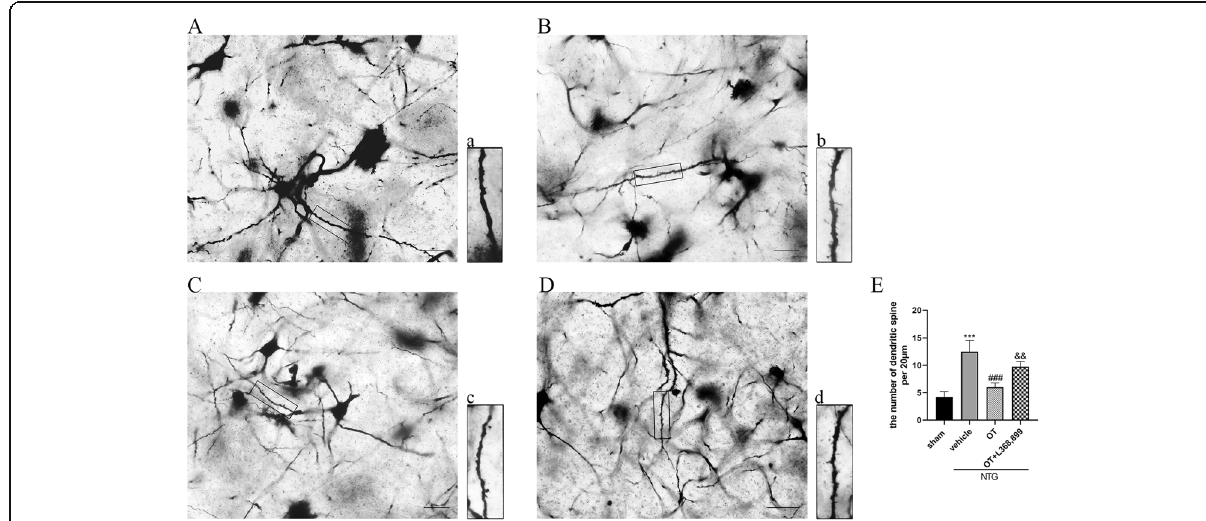
Fig. 8 Representative images and quantitative analysis of the dendritic spines in the TNC. A and a show the sham group, B and b show the NTG + vehicle group, C and c show the NTG + OT group, D and d show the NTG + OT + L368,899 group. a-d Magnification of the rectangle frame from each group was used to quantify the spine density in the four groups. E Golgi-Cox staining showed that the number of dendritic spines per 20 μ m was significantly higher in the NTG + vehicle group than in the sham group. The number of dendritic spines after OT treatment was reduced, while the effect of OT was inhibited by L368,899. One-way ANOVA with Dunnett ’ s post hoc test, n = 4/group; *** p < 0.001 vs. the sham group; ### p < 0.001 vs. the NTG + vehicle group; && p < 0.01 vs. the NTG + OT group; scale bars: 20 μ